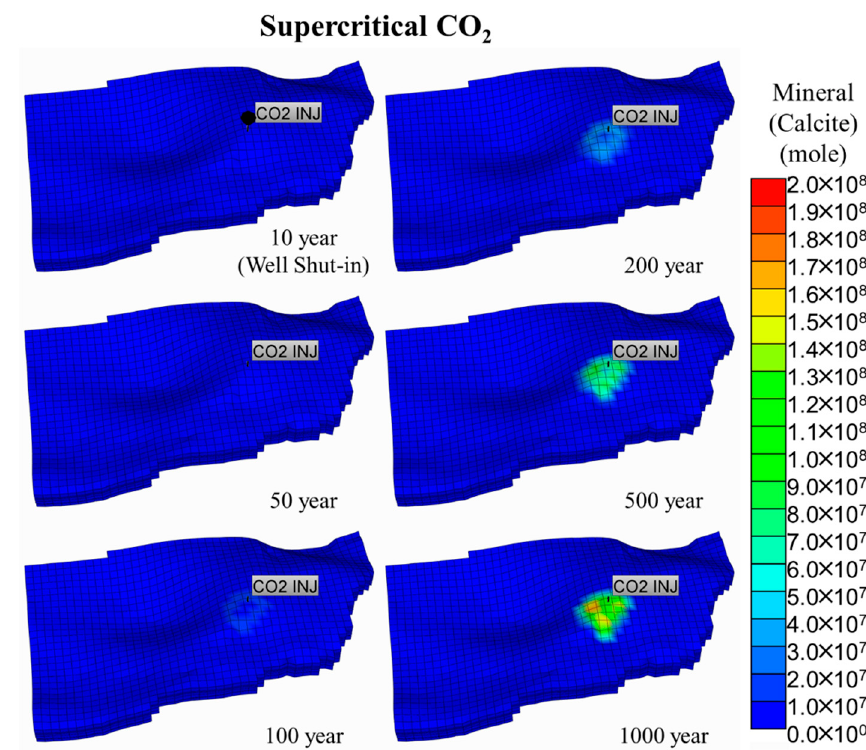
Figure 8. Spatial distribution of the change in moles of calcite in the supercritical CO 2 scenario. Energies 2020 , 13 , 5259